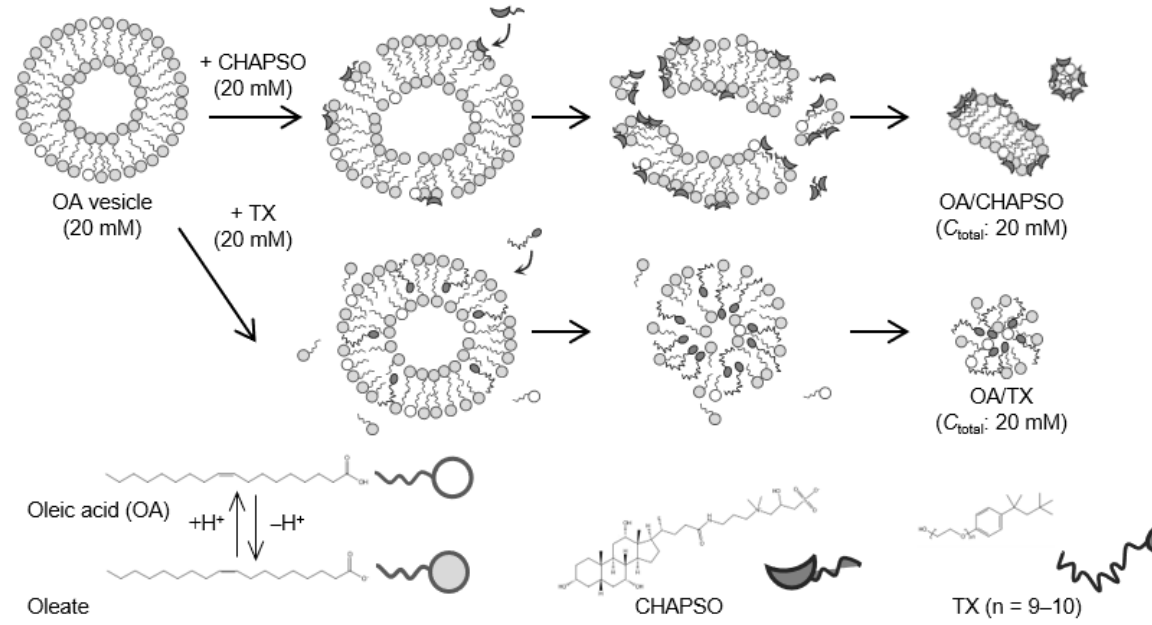
Figure 1. Outline of the OA/detergent (CHAPSO or TX) bicelle preparation.